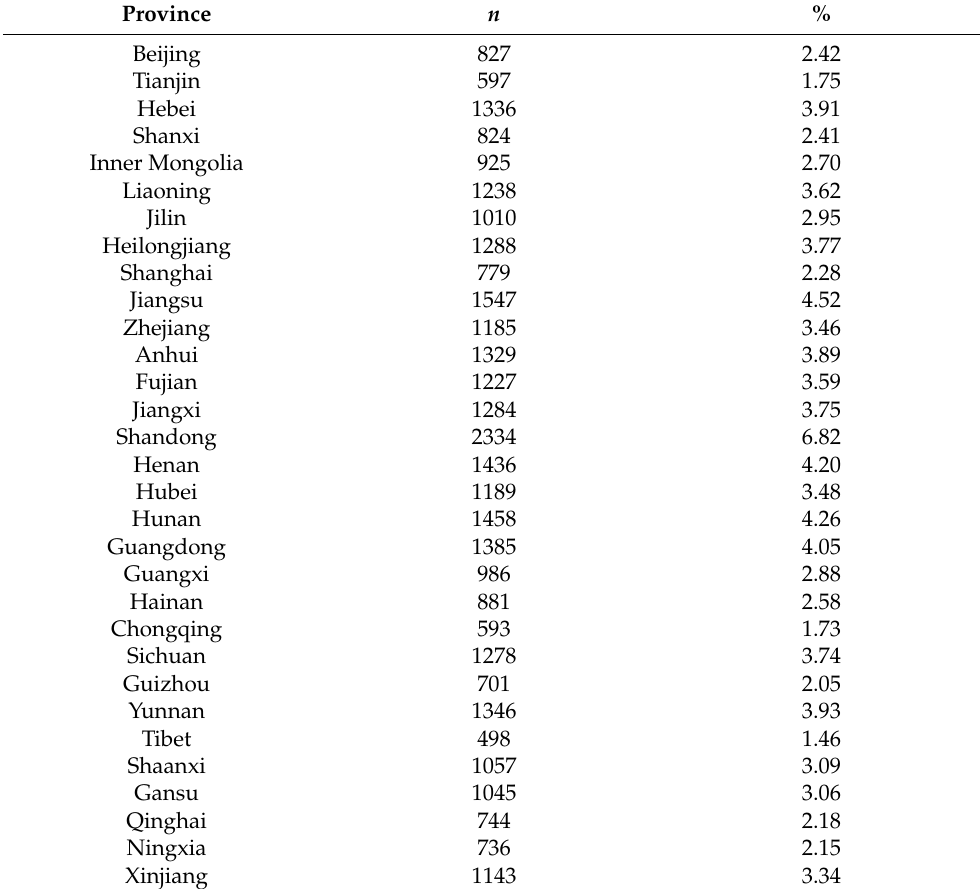
Table A1. Population distribution in 31 provinces.